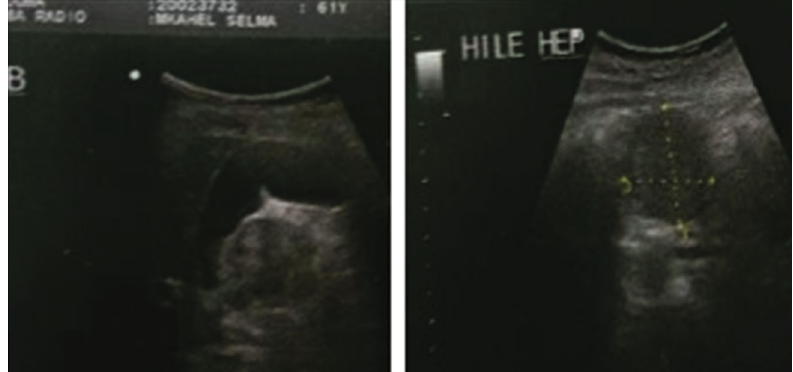
Figure 3: Abdominal ultrasound showing heterogeneous retroperitoneal nodular lesion, vascularized using color Doppler in presence of multiple partitions.